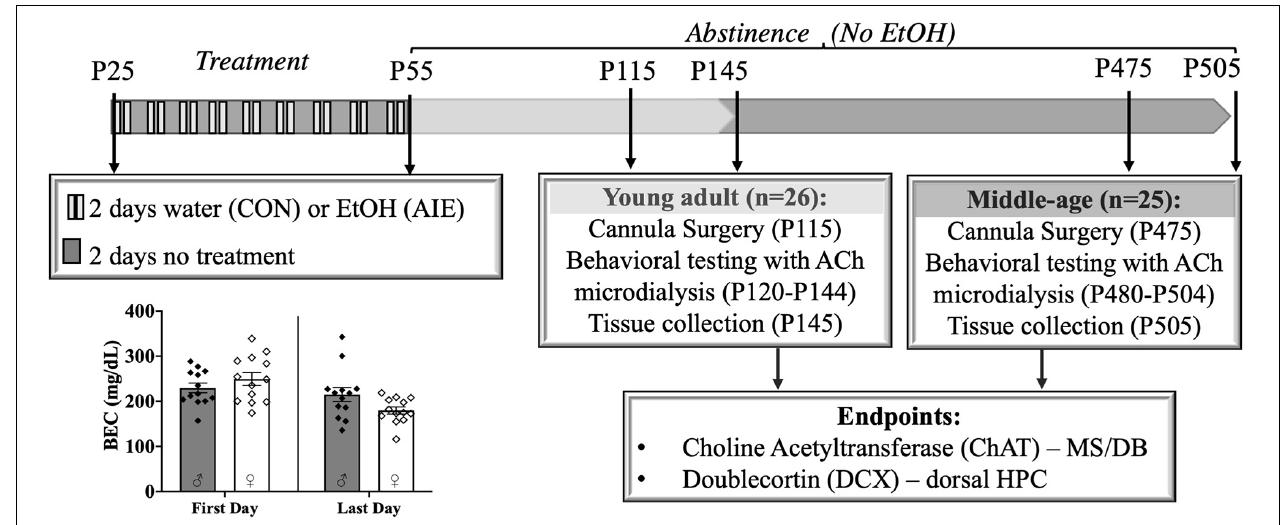
FIGURE 1 | Experimental timeline. Male and female rats were exposed to a binge-type gavage ethanol exposure (5.0 g/kg 20% EtOH v/v, i.g) or control water exposure on a 2-day on/2-day off administration schedule from postnatal day (P) 25 to P55. Blood ethanol content (BEC) of each animal was measured 1 h after the first EtOH exposure (P25) and 1 h after the final exposure (P55). BECs did not significantly differ between the males and females. Upon completion of treatment, rats were further randomly split into two age relevant time points, Young- Adult and Middle-age, for cannula implantation surgery, behavioral testing and tissue collection. Choline Acetyltransferase (ChAT) positive cells in the medial septum/diagonal band (MS/DB) and doublecortin (DCX) positive cells in dorsal hippocampus (HPC) were counted to document pathology in the septohippocampal pathway.